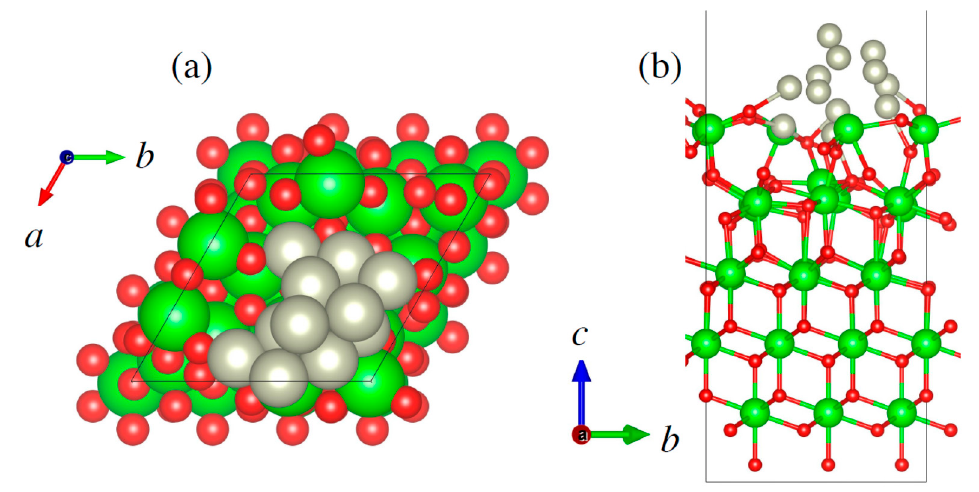
Figure 12. A Rh 12 cluster bound to a depression in a Zr-terminated surface, which was structurally relaxed by DFT calculations. The large green spheres represent Zr atoms, the small red spheres represent oxygen atoms, and the gray spheres represent Rh atoms. ( a ) is the top view and ( b ) is the side view.